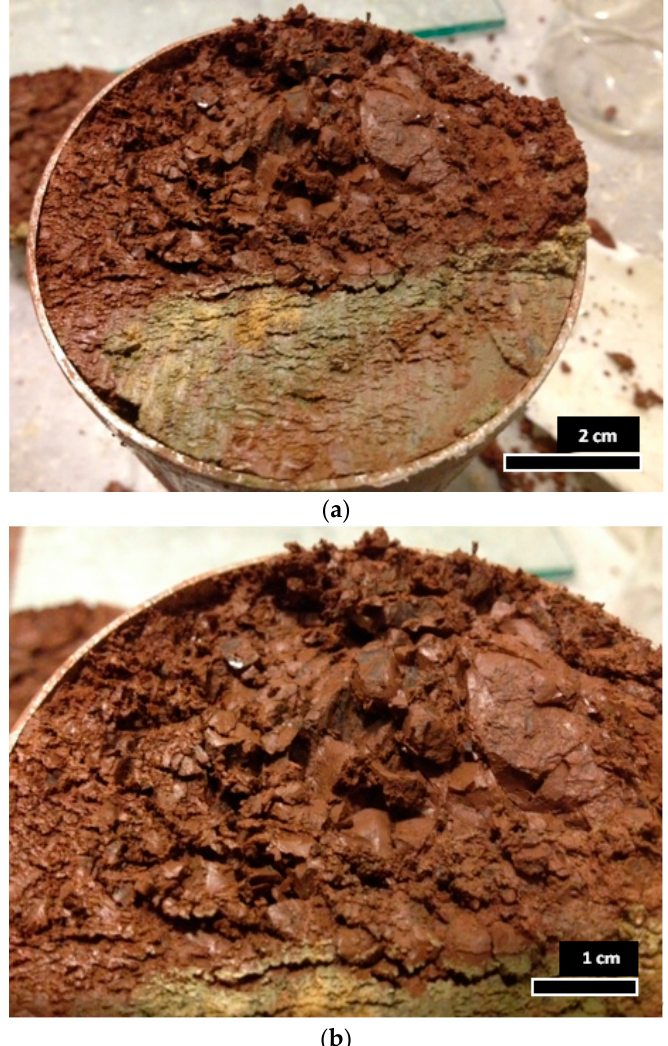
Figure 1. Undisturbed sample of Paola Doce fissured clay taken at 1.2 m depth at Pisciolo ( a ) and details of its meso-structure ( b ).